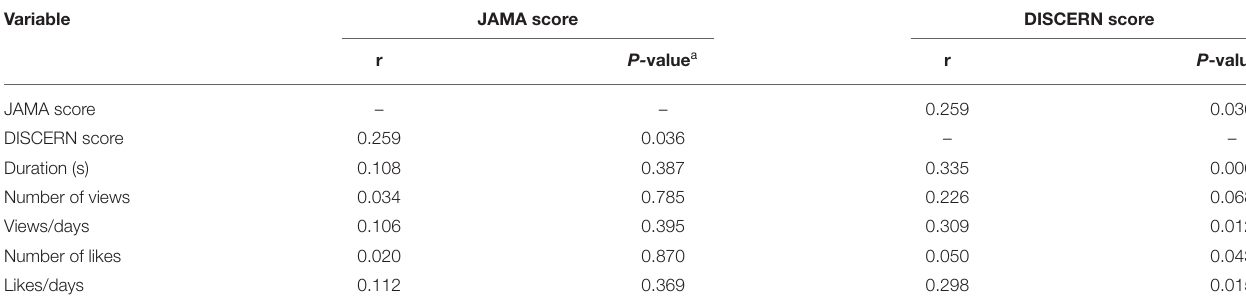
TABLE 6 | Correlation test for the factors influencing JAMA score and DISCERN score.